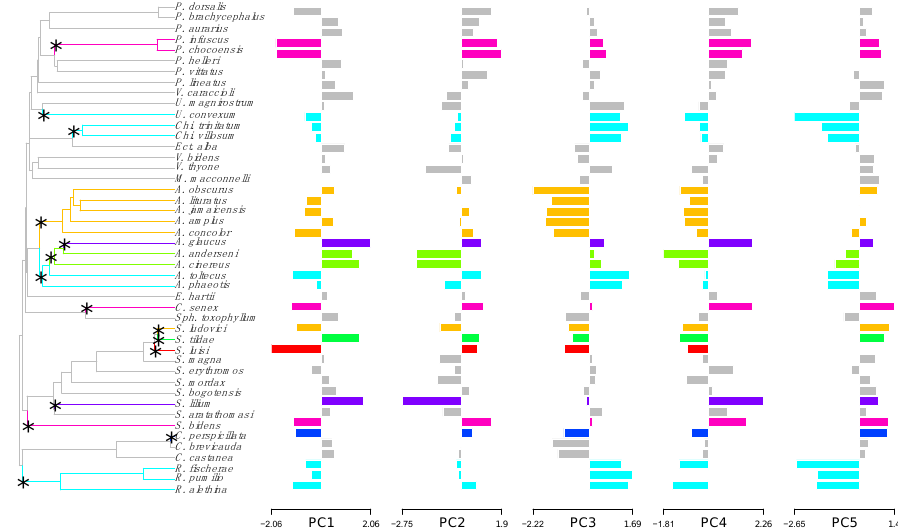
Figure 1. Shifts in adaptive peaks for jaw morphology of Neotropical frugivorous bats. Shifts in adaptive peaks are indicated with asterisks and convergent shifts in adaptive peaks have the same branch color.